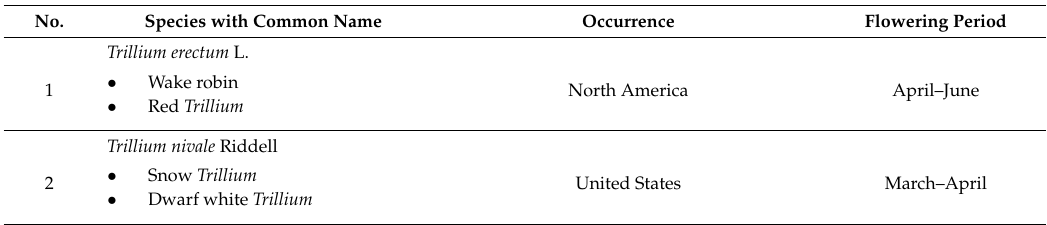
Table 1. Common species of the genus Trillium